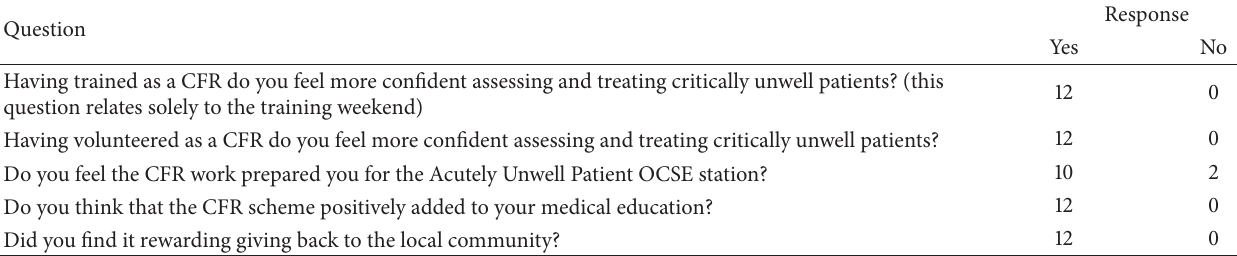
Table 3: Student responses to qualitative survey on educational value and community contribution ( 𝑛 = 12 ).